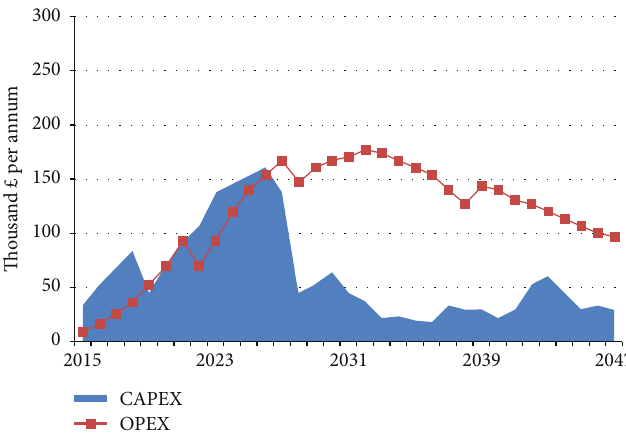
Figure 17: CAPEX and OPEX; DECC4, 2015 – 2047.